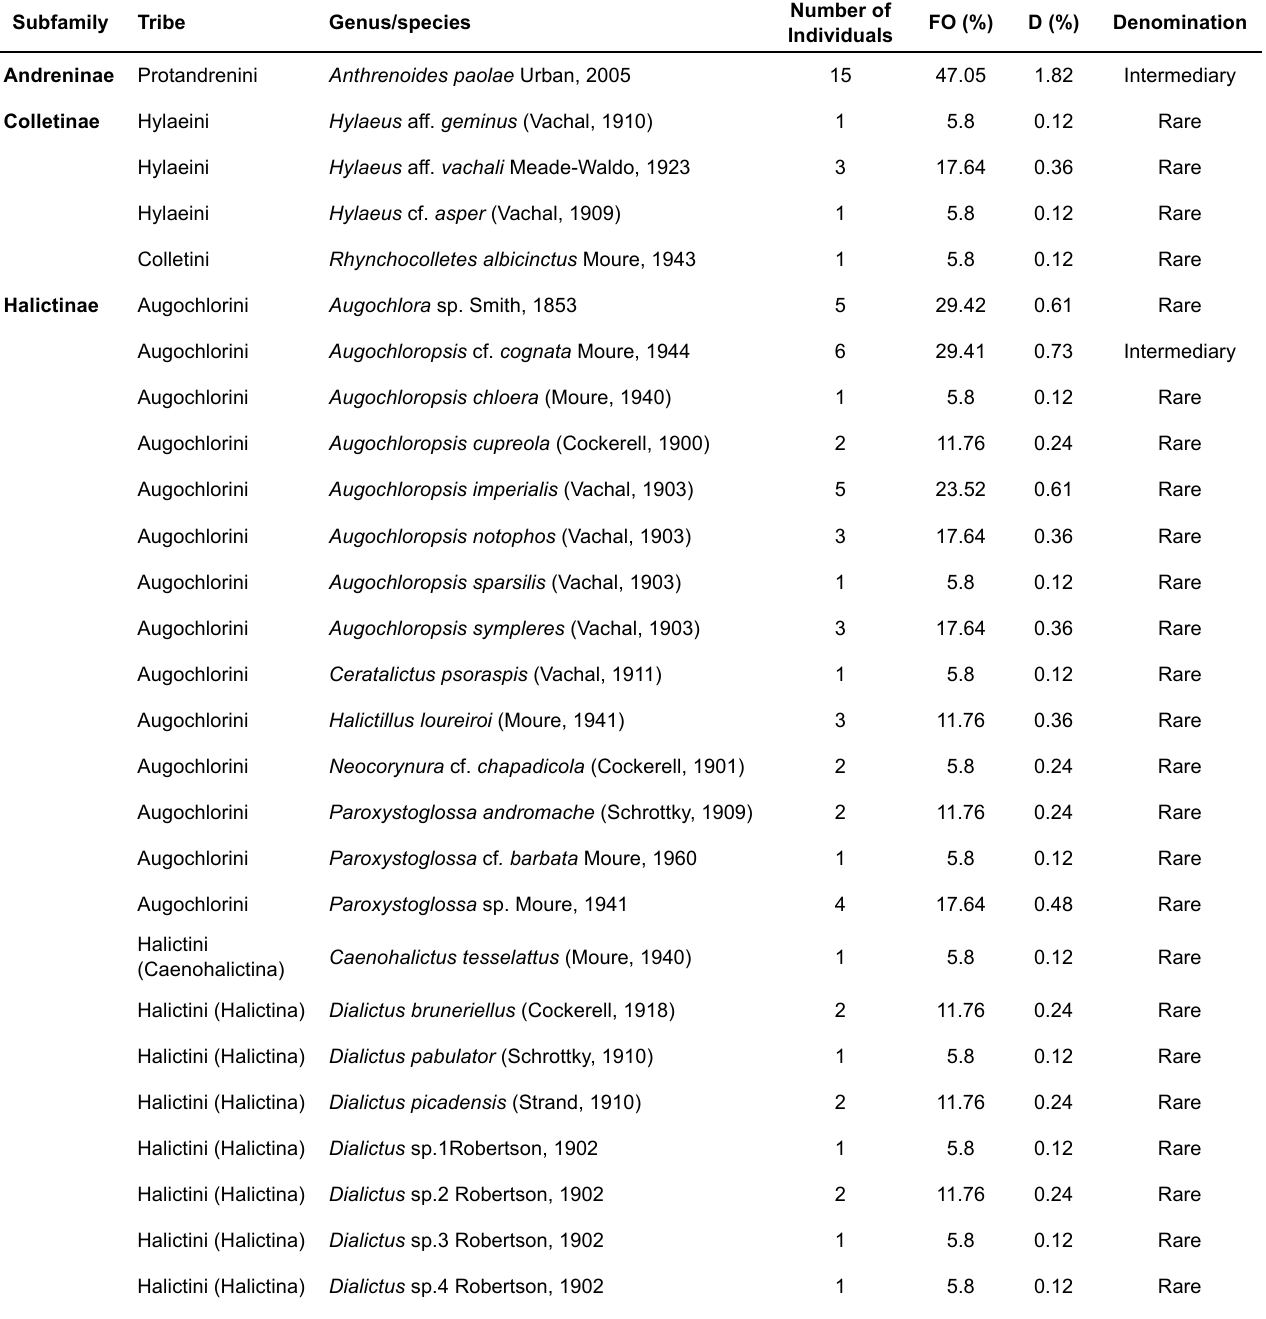
Table 1 - Species of flower visiting bees collected on Eugenia uniflora L. in fragments of mixed ombrophilous forest (Atlantic Forest) in south Brazil. Indices of frequency of occurrence (FO), dominance (D) and the denomination for each species of floral visitor